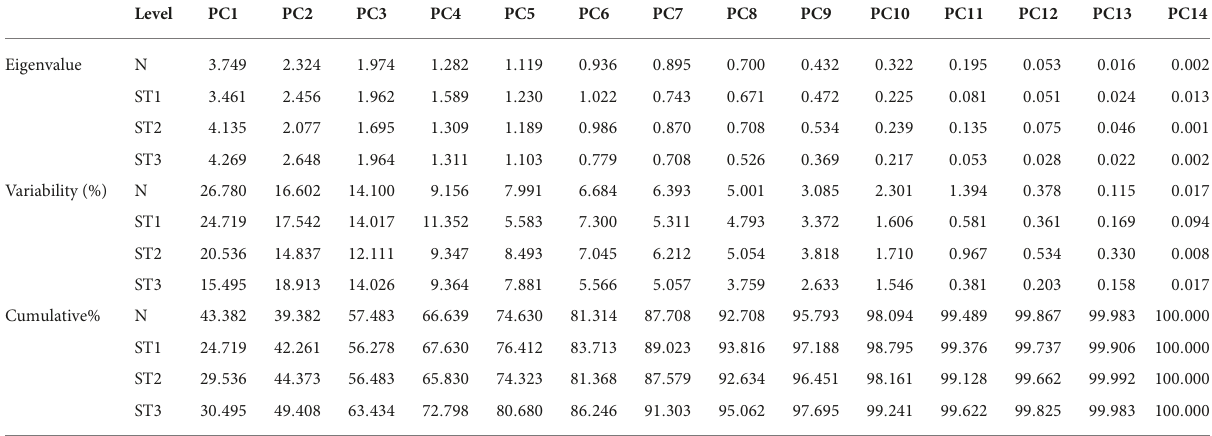
TABLE 4 Eigenvalues, variability, and cumulative of wheat seedling traits under normal and stress